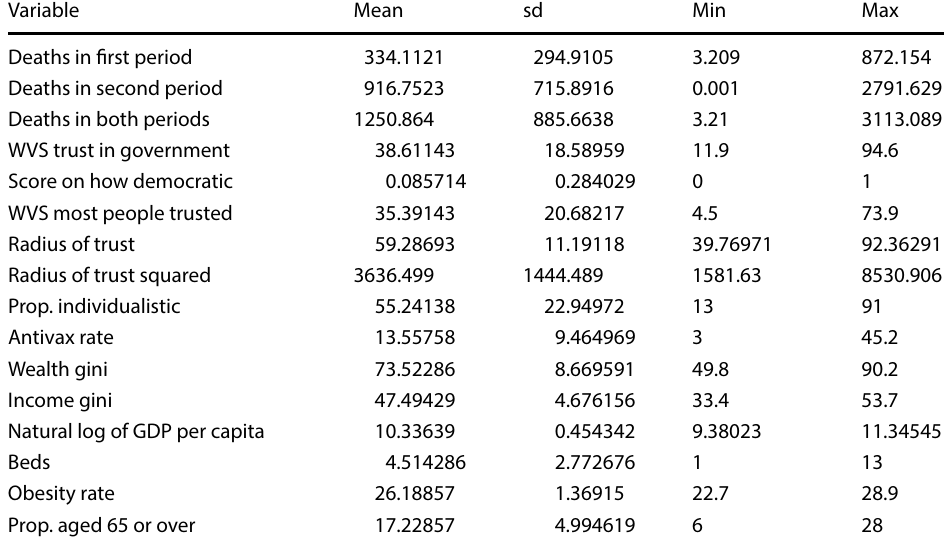
Sample: all countries used in analysis. Not all countries had values for all